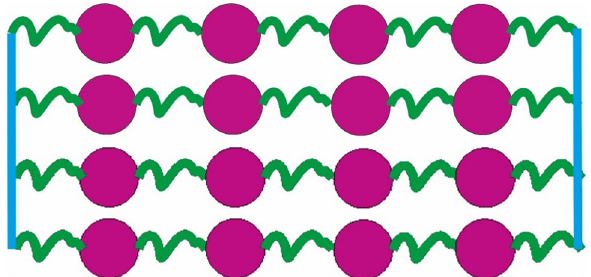
Fig. 5 A simplified tube